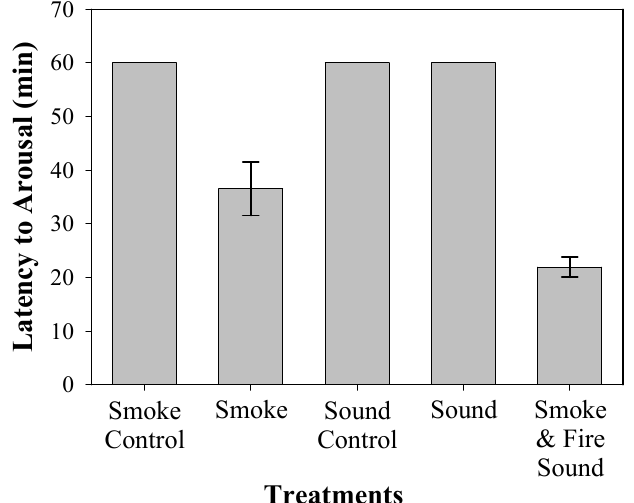
Figure 5. Arousal times of red bats ( n = 15) exposed to the different lab-based treatments. Bats that failed to arouse were given a value of 60 min. There was a difference between treatments (Friedman p < 0.05). Latency to arouse was shorter in the smoke treatment than the smoke control, and shorter in the smoke and fire sound combination than in the smoke treatment (Wilcoxon p < 0.05).